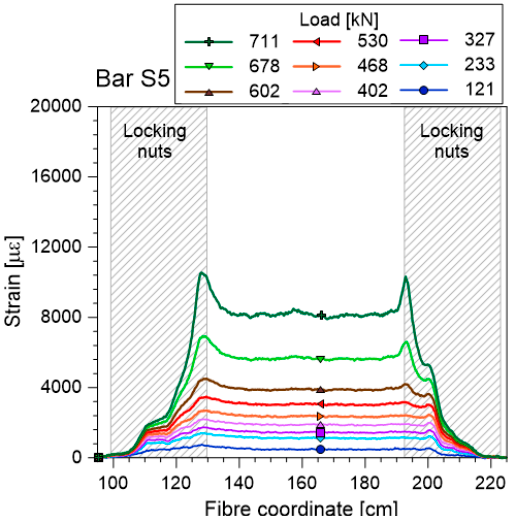
Figure 5. Strain recorded by DFOSs on simple bars (S1–S5) tested in the laboratory.